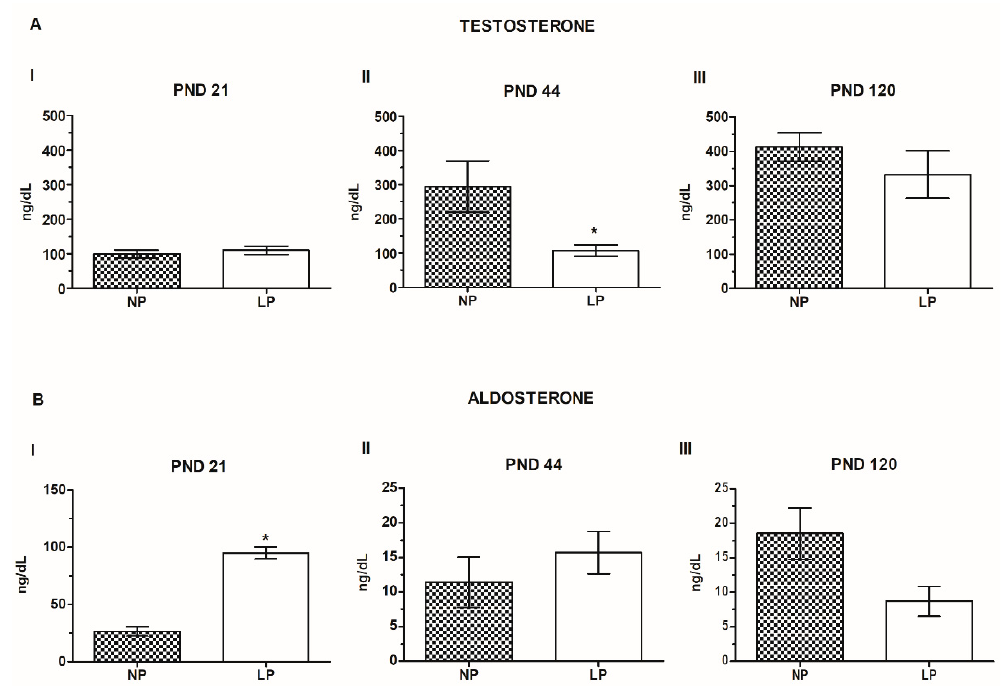
Figure 1. Serum hormones levels. ( A ) Plasma testosterone levels (ng/dL) at postnatal day (PND) 21 ( I ), PND 44 ( II ) and PND 120 ( III ), * p < 0.05 compared with the normoprotein (NP) group. ( B ) Plasma aldosterone levels (ng/dL) at PND 21 ( I ), PND 44 ( II ) and PND 120 ( III ), * p < 0.05 compared with the